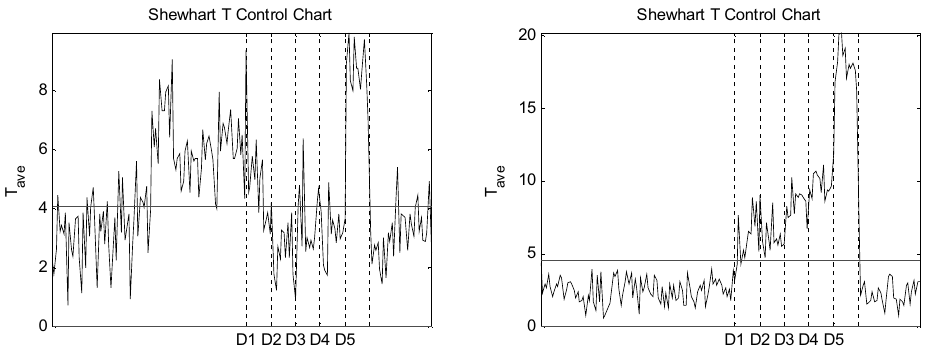
Fig. 5. Control charts of the largest PC:s of the AR coefficients with damage location 1. Left: without FA; right: with FA.